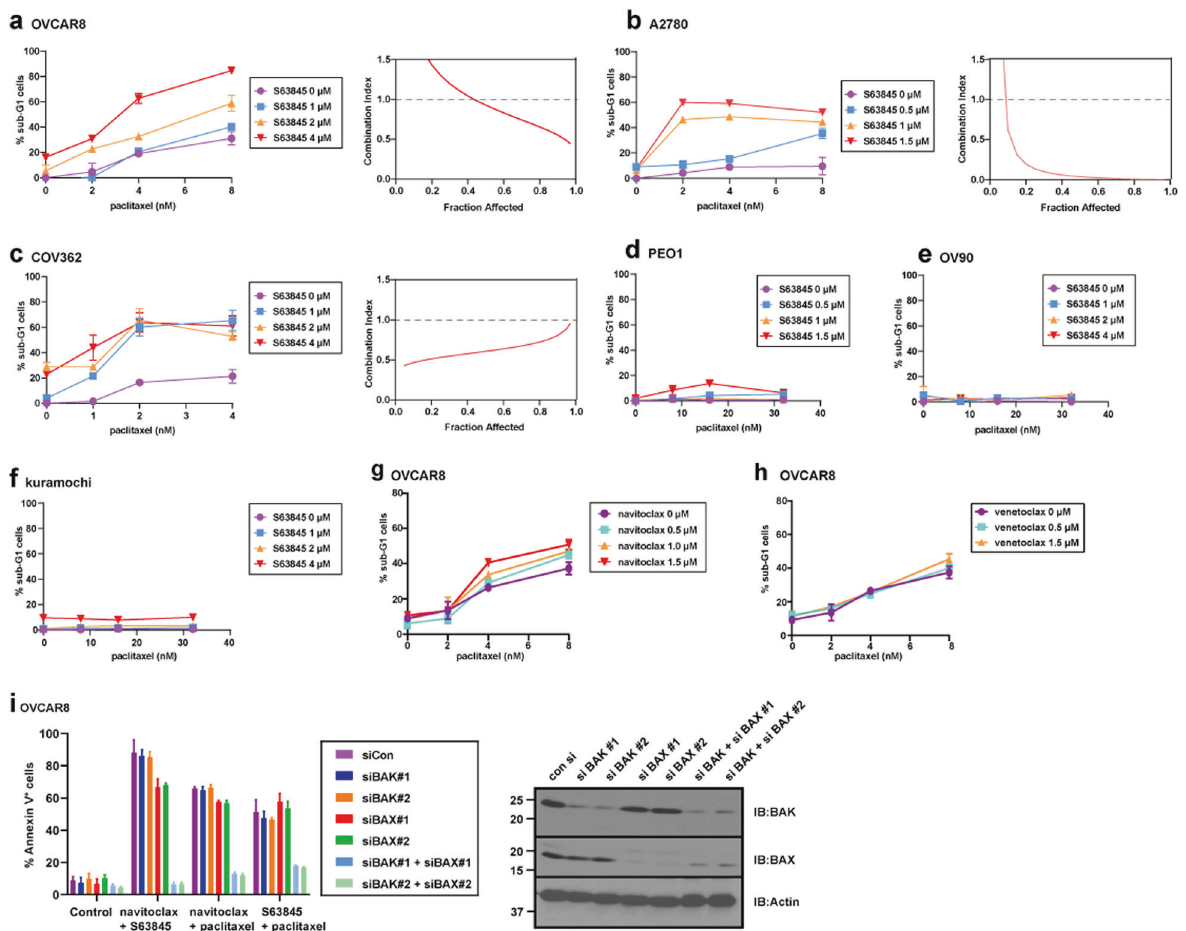
Fig. 6 S63845 and paclitaxel synergize in cells with BAK/MCL1 complexes. a – f After OVCAR8 ( a ), A2780 ( b ), COV362 ( c ), PEO1 ( d ), OV90 ( e ), and Kuramochi ( f ) were treated with paclitaxel in combination with S63845 at the indicated concentrations for 48 h, the percentages of sub- G1 cells were detected by fl ow cytometry. Right panels in a – c , combination indices (CIs) were calculated according to the method of Chou and Talalay [60] using all apoptosis data obtained from the left panels. This method calculates the CI, a parameter that indicates whether drug concentrations needed to produce a particular level of cell killing (% affected), are lower than, equal to, or greater than concentrations predicted to have additive effects. Thus, CI < 1 indicates synergy, CI = 1 indicates additivity, and CI > 1 indicates antagonism. g , h After OVCAR8 cells were treated with paclitaxel combined with navitoclax ( g ) or paclitaxel combined with venetoclax ( h ) at the indicated concentrations for 48 h, the percentages of sub-G1 cells were detected by fl ow cytometry. i Twenty-four hours after OVCAR8 cells were transfected with indicated siRNAs, cells were treated with navitoclax + S63845, navitoclax + paclitaxel, or S63845 + paclitaxel for 48 h, and assayed for Annexin V binding by fl ow cytometry. ( n = 3, independent experiments, mean ±